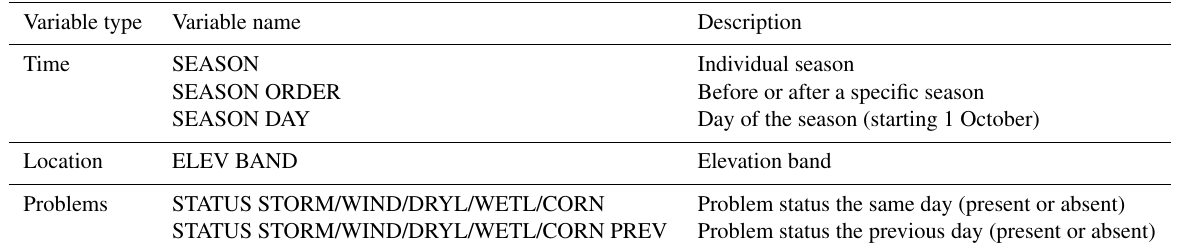
Table 4. Contextual variables describing the time, location, and other problems in the hazard